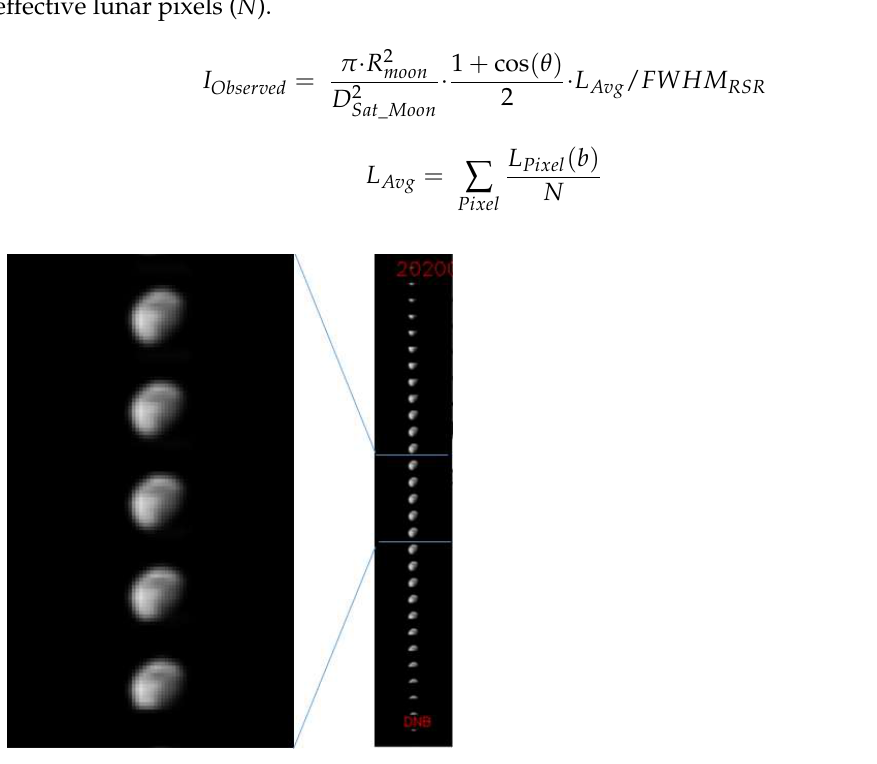
Figure 5. Radiance image of the scheduled lunar collection on April 4, 2020.